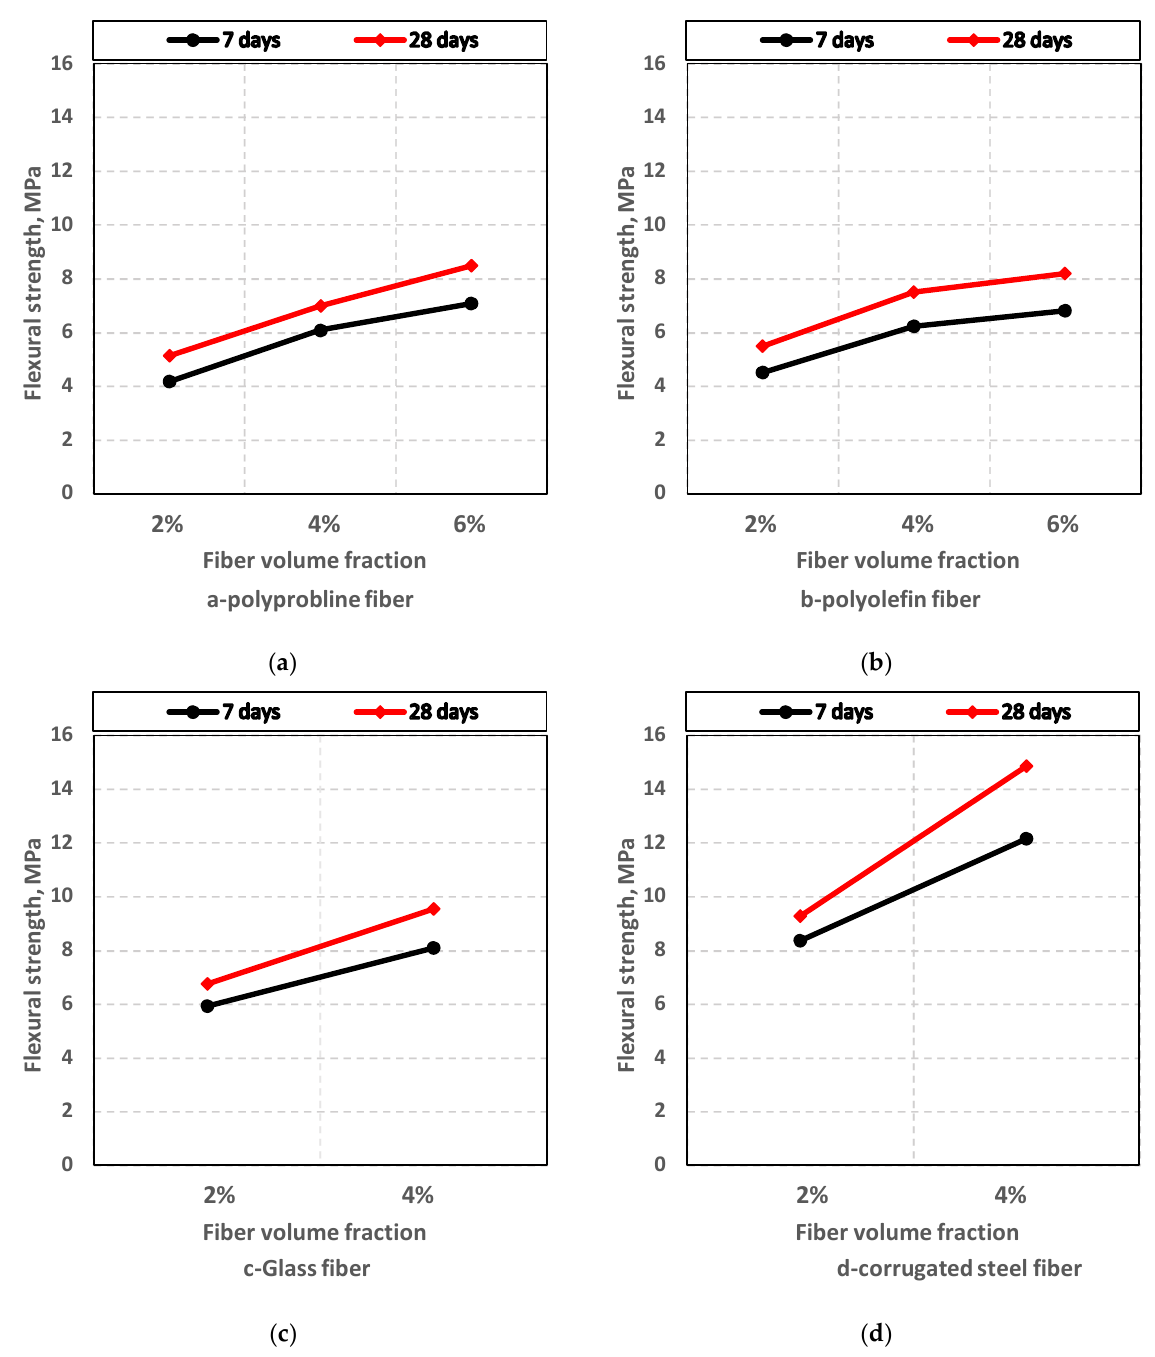
Figure 7. Flexural strength of FRC and ECC; ( a ) PP, ( b ) PO, ( c ) G.F, ( d ) C.S.F.